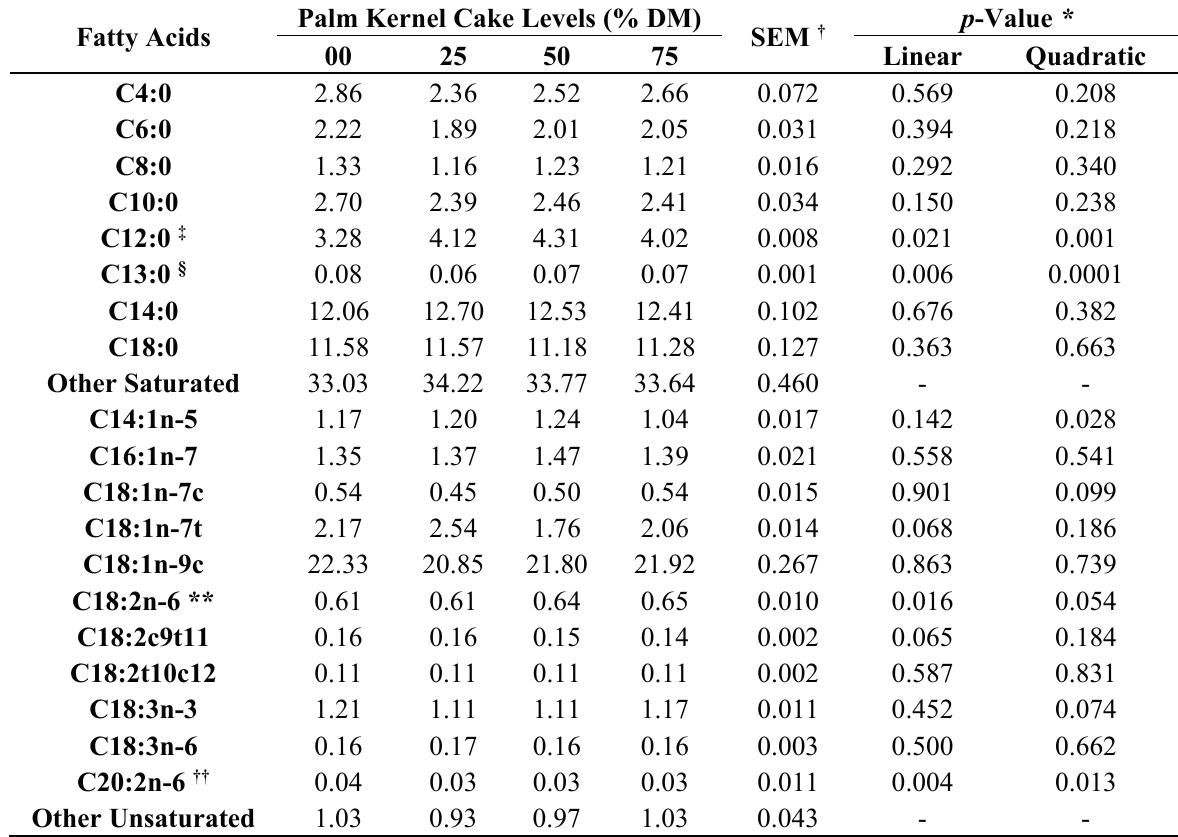
Table 3. The fatty acid profile (%) of the fat from fresh cheese that was produced with milk from pastured cows receiving supplements with palm kernel cake. Fatty